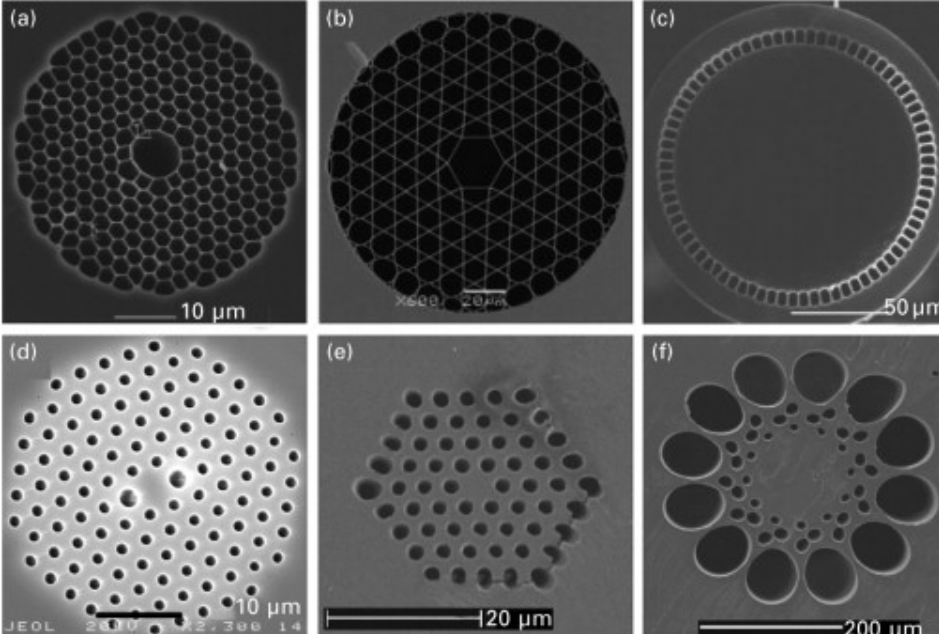
Figure 5. Examples of microstructured optical fibers (MOFs): ( a ) silica hollow-core photonic bandgap fiber (Humbert et al., 2004); ( b ) silica hollow-core Kagome lattice fibre (Couny et al., 2006) which is guided by the inhibited coupling mechanism (Argyros and Pla, 2007); ( c ) silica hi-NA fiber (Wadsworth et al., 2004b), © IEEE; ( d ) silica birefringent fiber (Xiong and Wadsworth, 2008); ( e ) single-mode mPOF; ( f ) high-bandwidth mPOF [39].